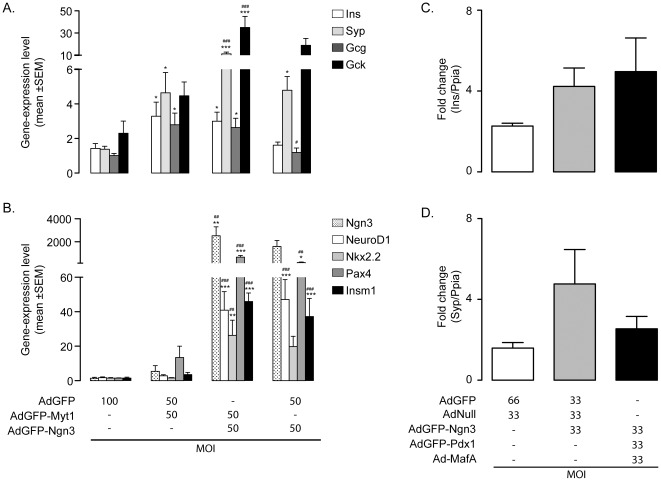
Overexpression of pancreatic endocrine transcription factors in adult human duct cells.(A, B) Effect of Myt1b overexpression in adult human duct cells. Adult human duct cells have been transduced with AdGFP, AdGFP-Ngn3 and/or AdGFP-Myt1 with a total MOI 100 and gene expression profiles have been analyzed 10 dpt. (A) Increased levels of several neuroendocrine genes are observed in AdGFP-Myt1 duct cells. The effects are enhanced by overexpression of Myt1 and Ngn3. (B) Except for Pax4, Myt1 does not upregulate known Ngn3 target genes. P<0.05 vs AdGFP (*) or AdGFP-Myt1 (#); P<0.005 vs AdGFP (**) or AdGFP-Myt1 (##); P<0.001 vs AdGFP (***) or AdGFP-Myt1 (###). (C, D) Adenoviral overexpression of Pdx1, Ngn3 and MafA in adult human duct cells does not induce the neuroendocrine genes Ins and Syp. Adult human duct cells have been transduced with control viruses AdGFP and AdNull, AdGFP-Ngn3+AdGFP+AdNull or AdGFP-Pdx1+AdGFP-Ngn3+AdMafA with a total MOI of 100 and gene expression has been analyzed 10 dpt. RT-qPCR analysis reveals that none of these conditions induced insulin or synaptophysin transcripts. Data represent mean ± SEM real-time PCR measurements of target/Ppia mRNA levels compared to non-transduced adult human duct cells (n ≥3).